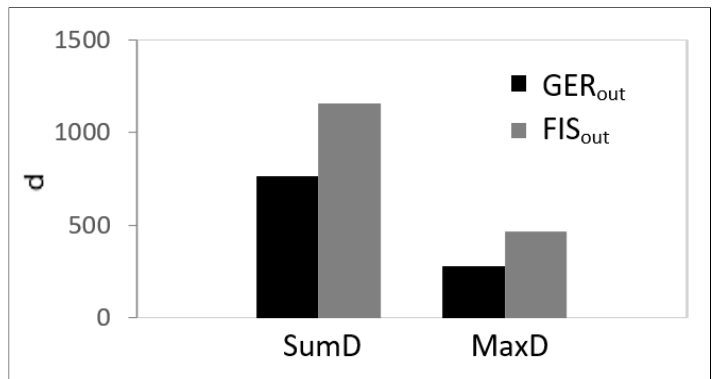
Figure 11. Total SumD and MaxD values for the MAM threshold in GER out and FIS out